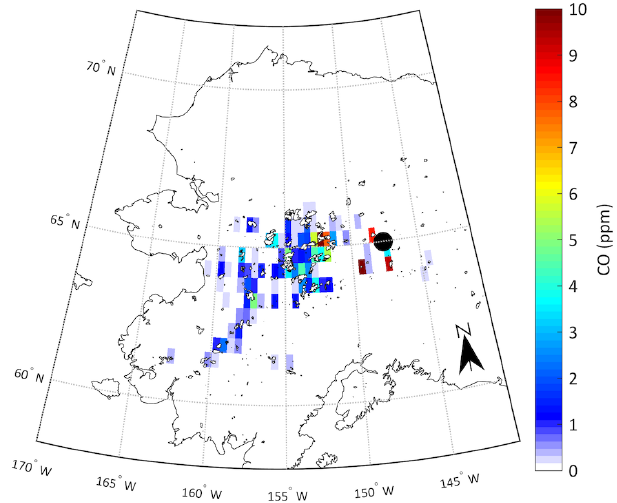
Figure 9. Individual fire contributions to the total fire season inte- gral of CO anomalies measured at the CRV tower, as determined by convolving footprints from PWRF-STILT with fire emissions from AKFED. The location of CRV is shown as a black circle. Fire perimeters are shown in